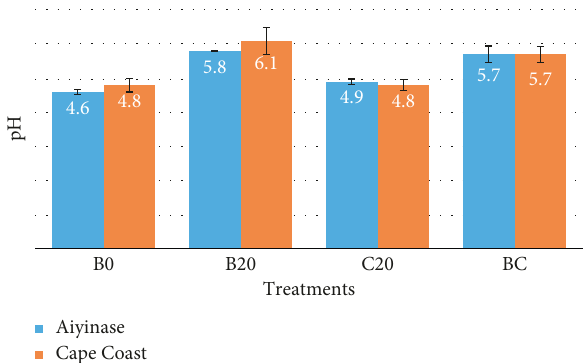
Figure 1: Changes in soil pH of the Aiyinase and Cape Coast soils following application of corncob biochar and/or compost 14 days after incubation. B0 � control with no amendments; B20 � biochar 2%, w/w; C20 � compost 2%, w/w; BC � combined biochar and compost rate 1% compost+1% biochar. Error bars represent standard deviation of the